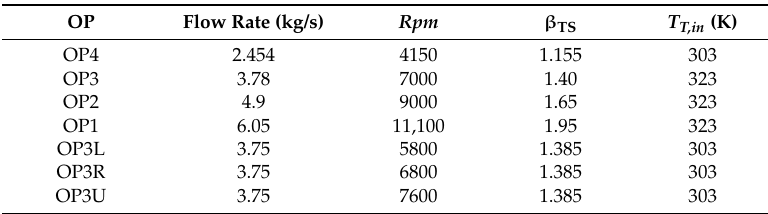
Table 3. Main flow quantities for different OP.